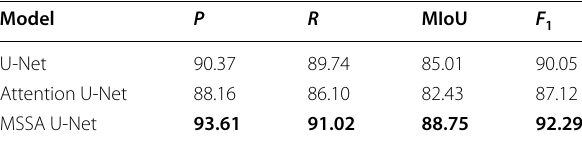
Bold values indicate that the detection accuracy of the proposed method is significantly better than that of other methods